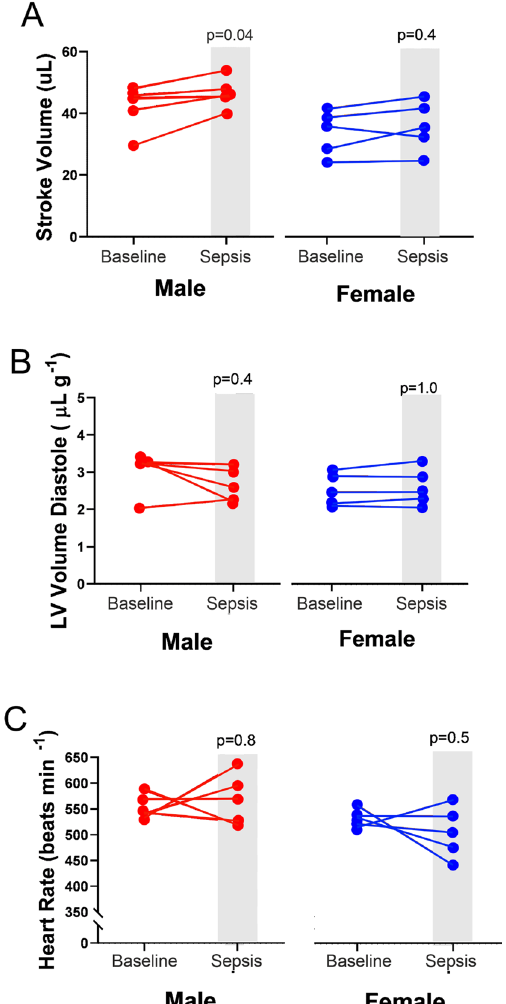
Fig. 8 Loss of TNFα shedding in iRHOM2 deficiency and cardiac function after polymicrobial sepsis. A Summary data for stroke volume in male and female iRHOM2-deficient mice ( n increased only in both wild-type male mice. Data for each individual mouse were compared to its own pre-sepsis baseline reading, measured ~ 1 week before the onset of sepsis. Individual p values on each panel refer to post hoc testing after ANOVA testing for sex x time interaction. B Left ventricular volume (standardised by body weight) in iRHOM2-deficient male and female mice ( n after 18 h sepsis. Data for each individual mouse were compared to its own pre-sepsis baseline reading, measured ~ 1 week before the onset of sepsis. Individual p values on each panel refer to post hoc testing after ANOVA testing for sex x time interaction. C Heart rate in male and female iRHOM2-deficient mice ( n as indicator of preload after 18 h sepsis. Data for each individual mouse were compared to its own pre-sepsis baseline reading, measured ~ 1 week before the onset of sepsis. Individual p values on each panel refer to post hoc testing after ANOVA testing for sex x time